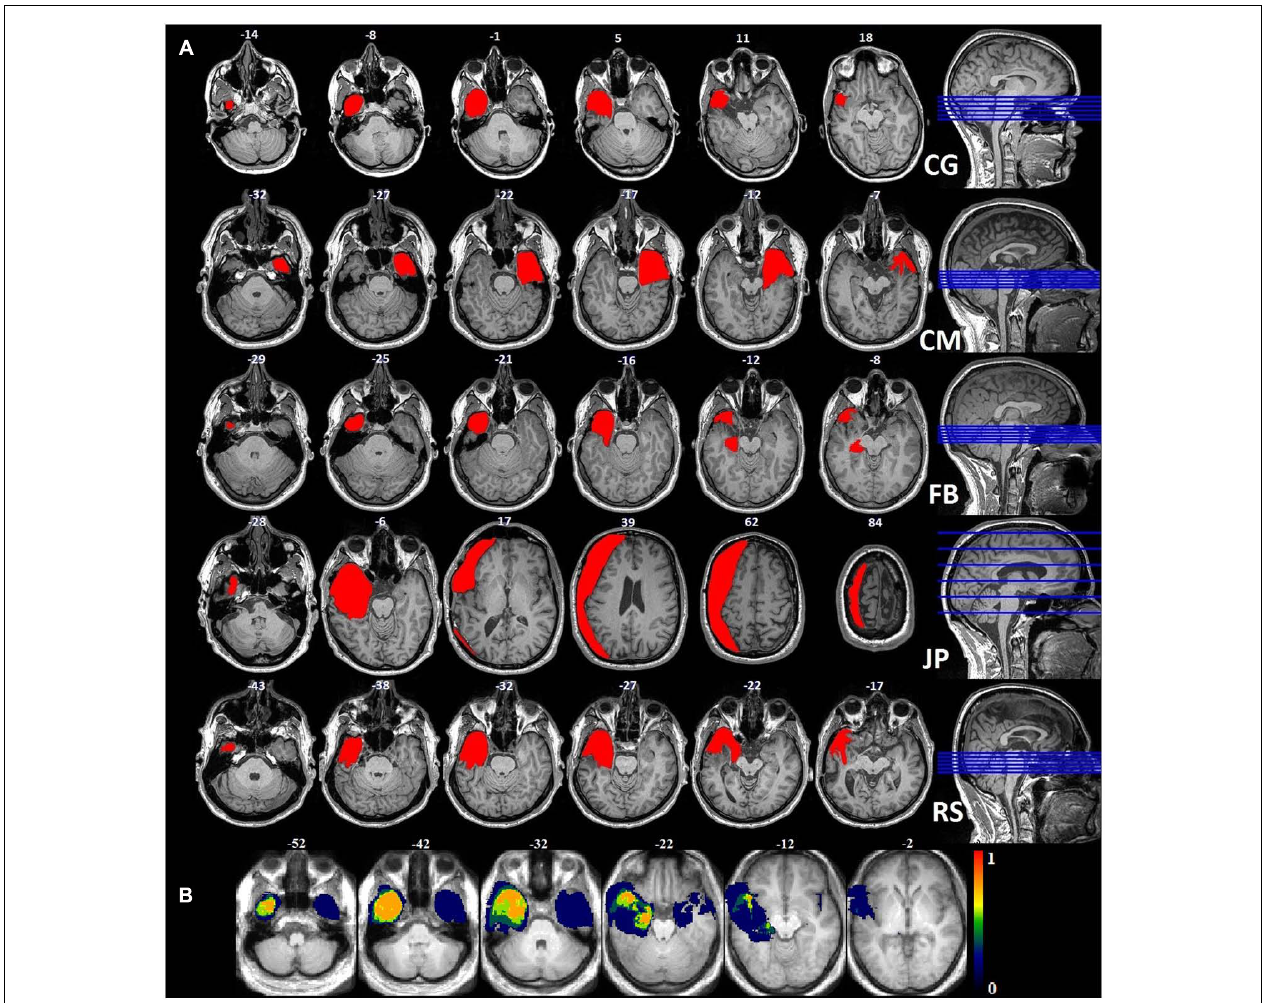
FIGURE 1 | (A) Anatomical images of the lesions for each patient: each lesion was delineated manually on the axial plane and corrected using the coronal plane. (B) Probability map for the normalized lesion size.